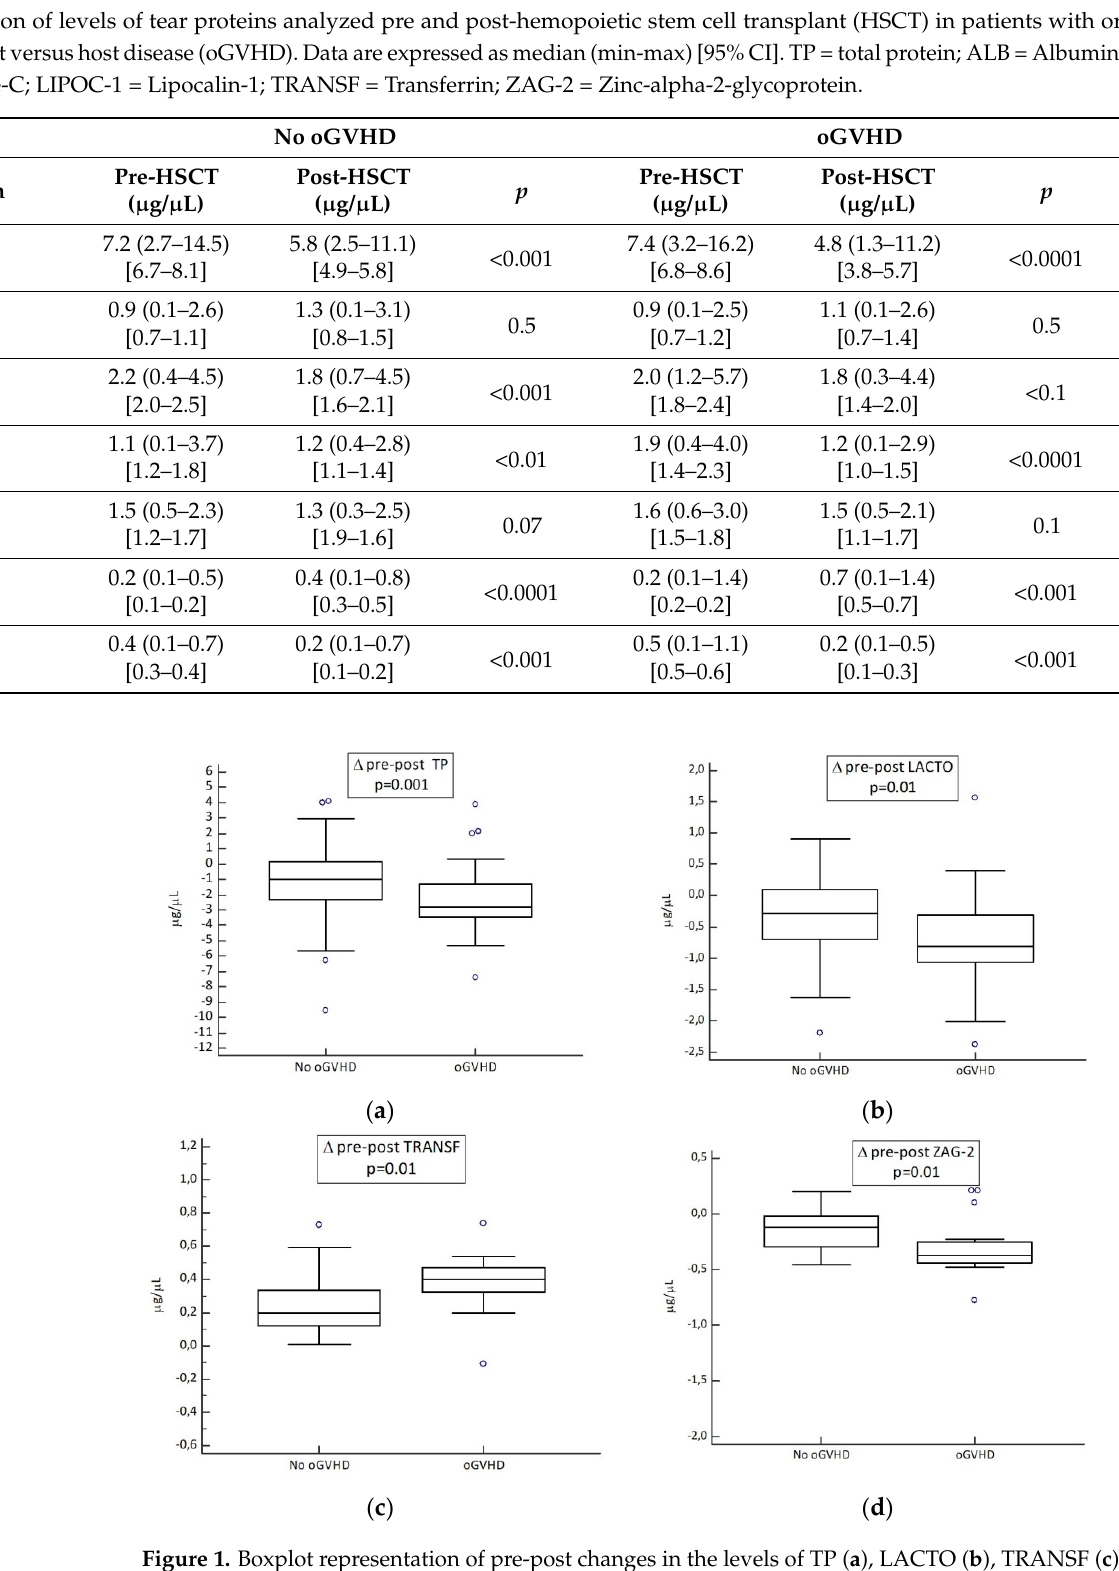
Table 4. Comparison of levels of tear proteins analyzed pre and post-hemopoietic stem cell 178 transplant (HSCT) in patients with or without ocular graft versus host disease (oGVHD). Data are 179 expressed as median (min-max) [95% CI]. TP = total protein; ALB = Albumin; LYS-C = Lysozyme- 180